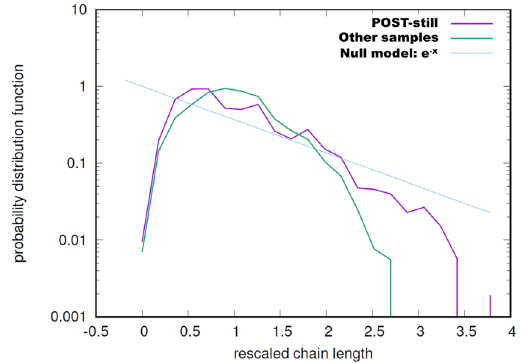
Figure 5. Chain spectra in POST-still cluster (see Fig. 4) and in all the other clusters taken as a single group compared to the null model in which chain separation is stochastically regulated 42